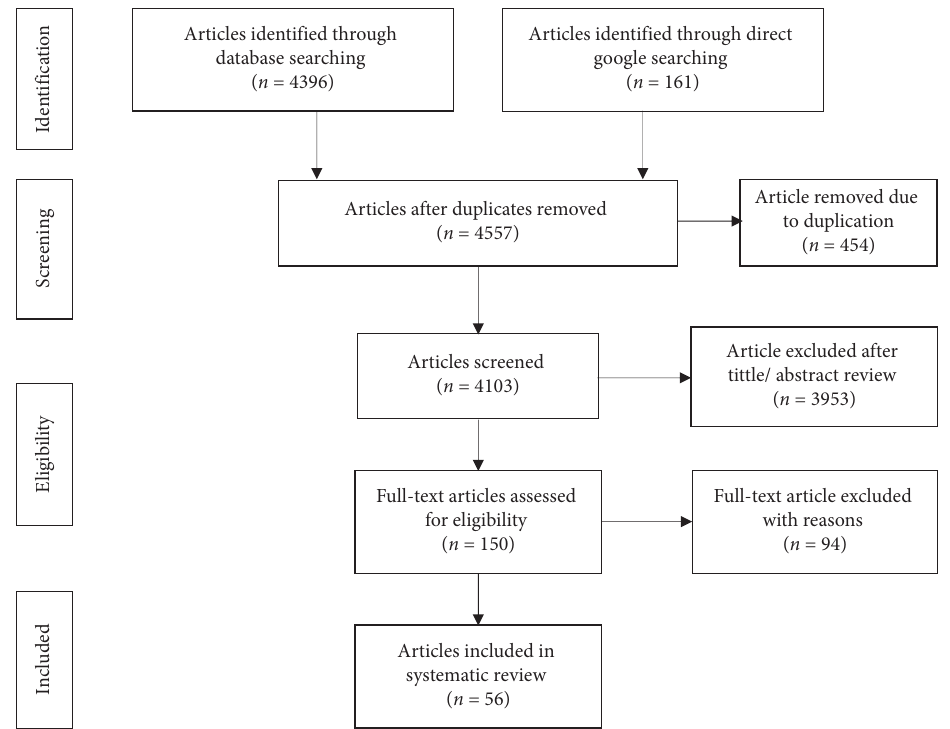
Figure 1: PRISMA flow diagram for identification and selection of articles for inclusion in the